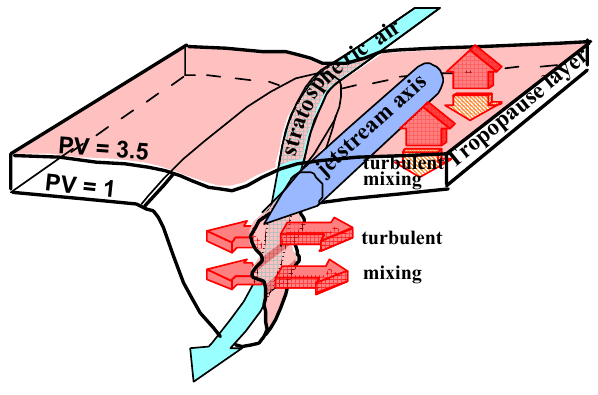
Fig. 11. Schematic representation of the mixing process observed by the radar and lidar network in the observed tropopause folding and in its vicinity . Turbulence regions (in red) occur in wind shear regions generated by the jet stream (i) within the fold and along its anticyclonic boundary, (ii) just above the thermal tropopause ( PV = 3 . 5 PV